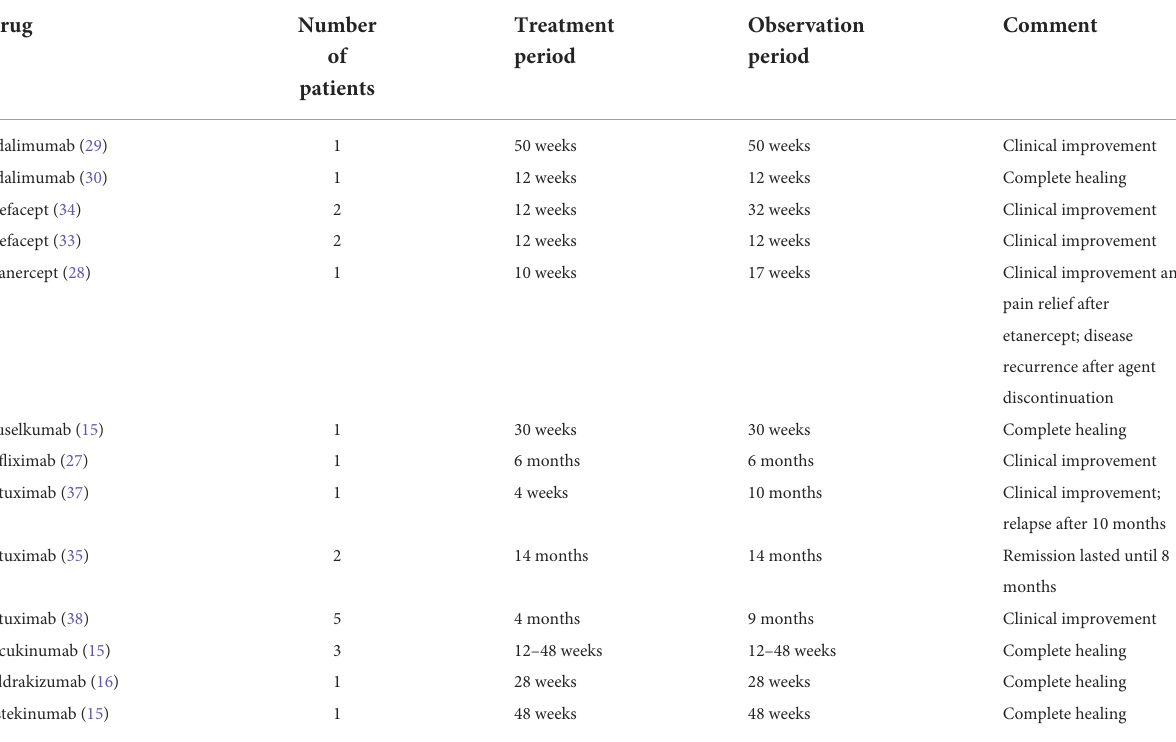
TABLE 2 Patients with oral lichen planus treated with biologics.